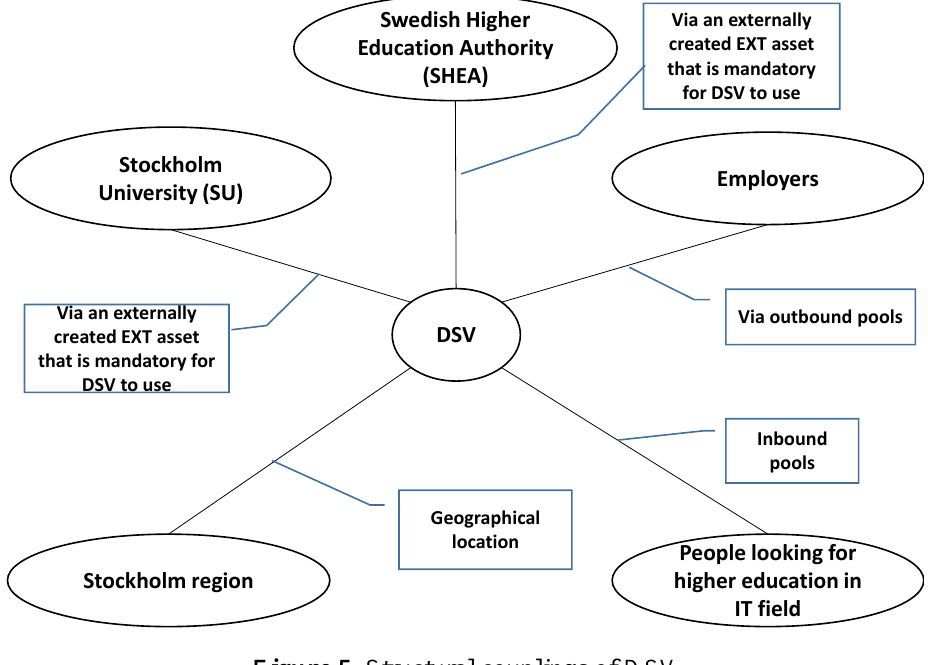
Figure 5. Structural couplings of